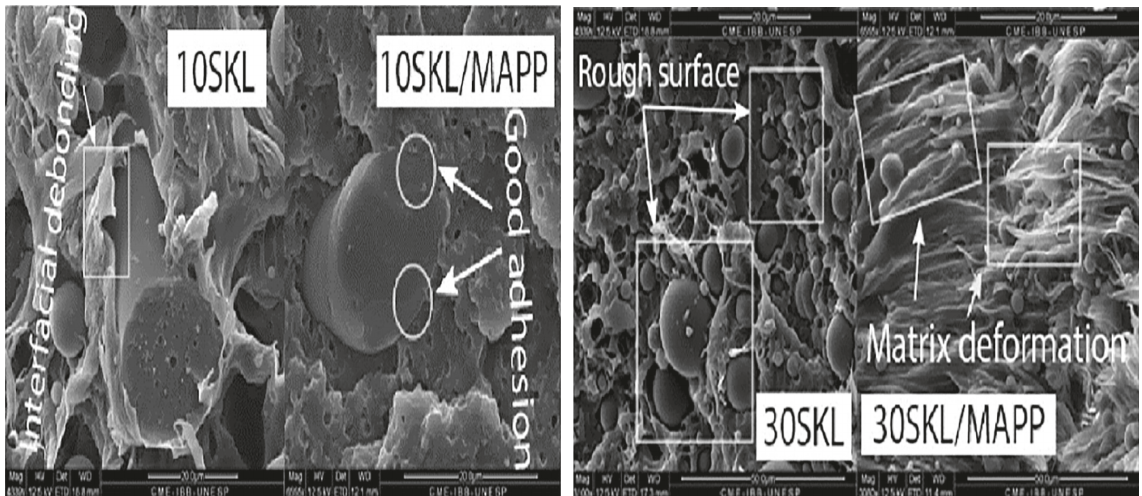
Figure 9: SEM photographs of lignin and lignin-based biocomposites containing different concentrations of lignin [92] (Copyright @ 2018 John Wiley & Sons).